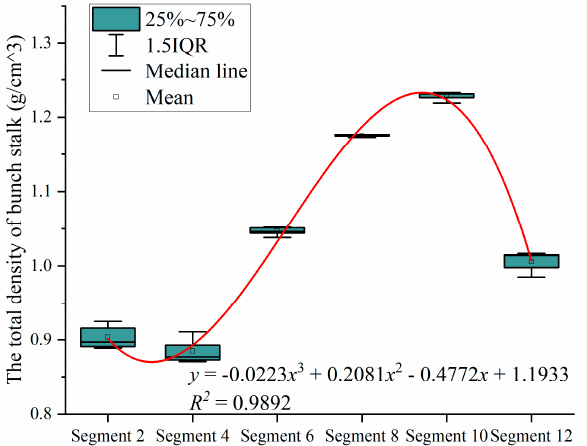
Figure 11. The relationship between the total density of bunch stalks and the segments.